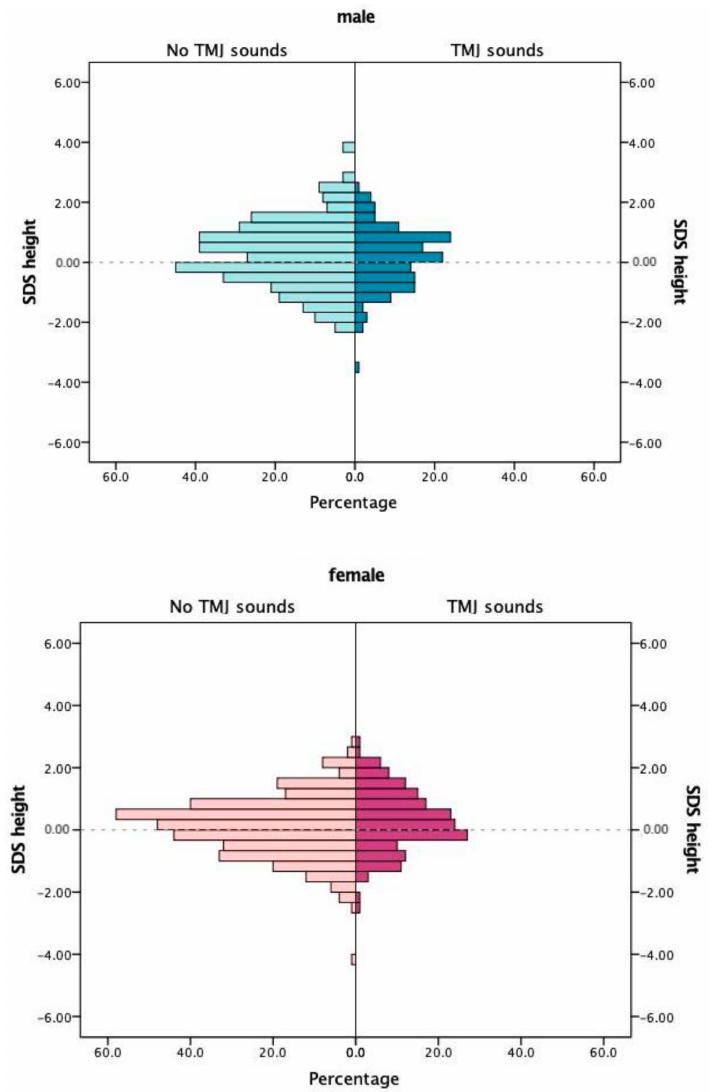
Figure 1. Standard deviation scores (SDS) of body height in relation to temporomandibular joint